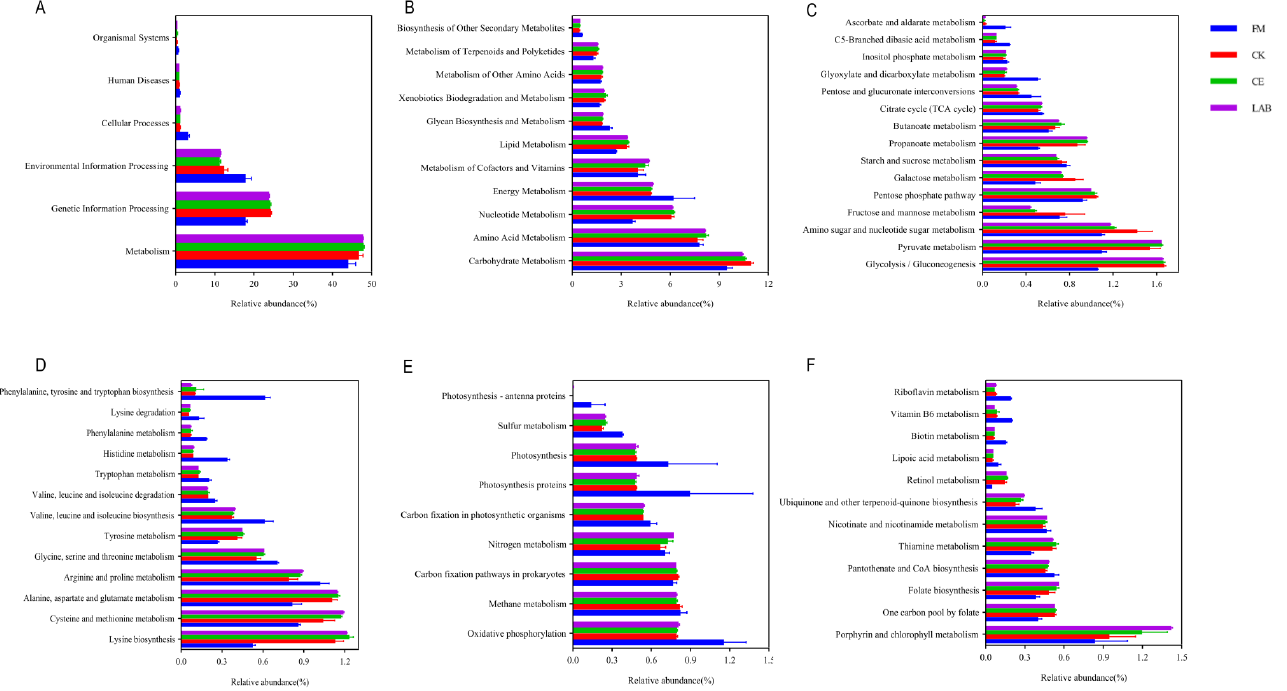
Figure 5. Bar graphs showing 16S rRNA gene‑predicted functional profiles for fresh material and after 60 days of ensiling on the first ( A ), second ( B ) pathway levels, carbohydrate metabolism ( C ), amino acid metabolism ( D ), energy metabolism ( E ), and metabolism of cofactors and vitamins ( F ) of the third pathway level. FM, fresh material; CK, no additive control; CE, cellulase; LAB, lactic acid bacteria.